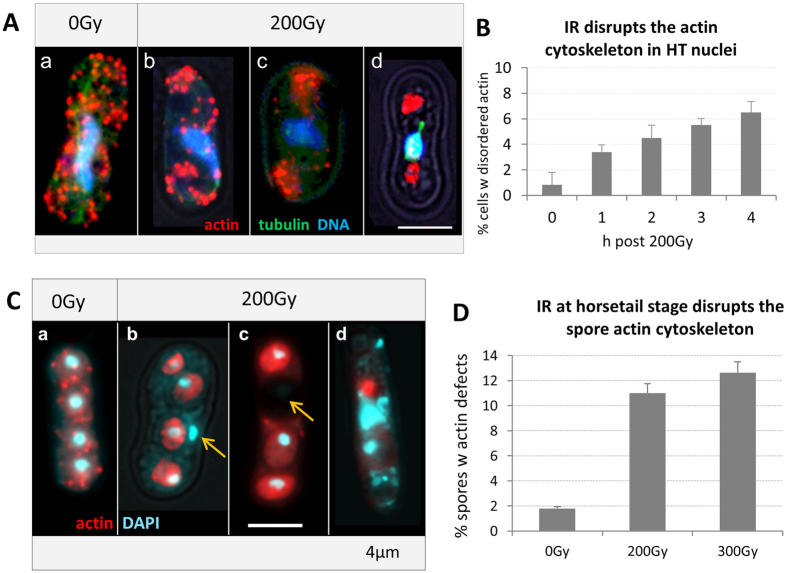
The actin cytoskeleton of horsetail cells.Actin is stained in red, tubulin in green, DNA in blue (DAPI). Maximum projections of image stacks shown. (A, a) Non-irradiated horsetail cell displaying a normal actin cytoskeleton characterized by numerous cortical patches that are of similar size and distributed throughout the cell. Irradiation with 200 Gy leads to an aggregation of the actin patches (A, b–d). (B) The percentage of cells with disordered actin distribution increases with time after 200 Gy X IR. (C) Actin (red) and DNA (blue) distribution in control (a) and ascospores formed after 200 Gy irradiation of horsetail cells (b–d). (b) IR-induced DNA fragmentation leads to DAPI bodies (light blue) outside spores (arrow). (c) The actin cytoskeleton fails to form patches and is sometimes absent in spores that lack DNA (arrow). (d) Ascus showing severely damaged nuclei, spores and precipitated actin (red dot). Bar: 4 μm. (D) Irradiation in the horsetail stage induces defective ascospores. Percentage of ascospores investigated (>150 from 3 different experiments; ±SD).